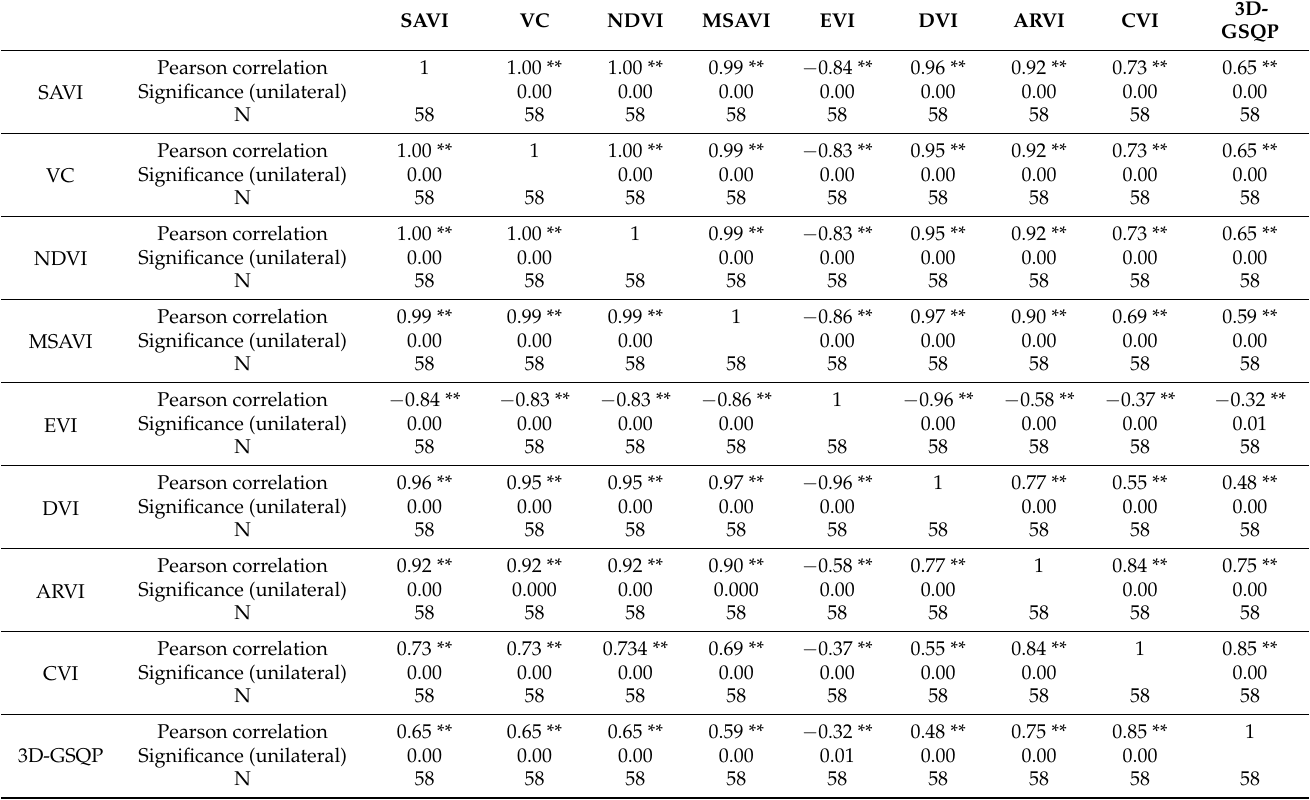
Table 4. The statistics of 3D-GSQ in the urban area of